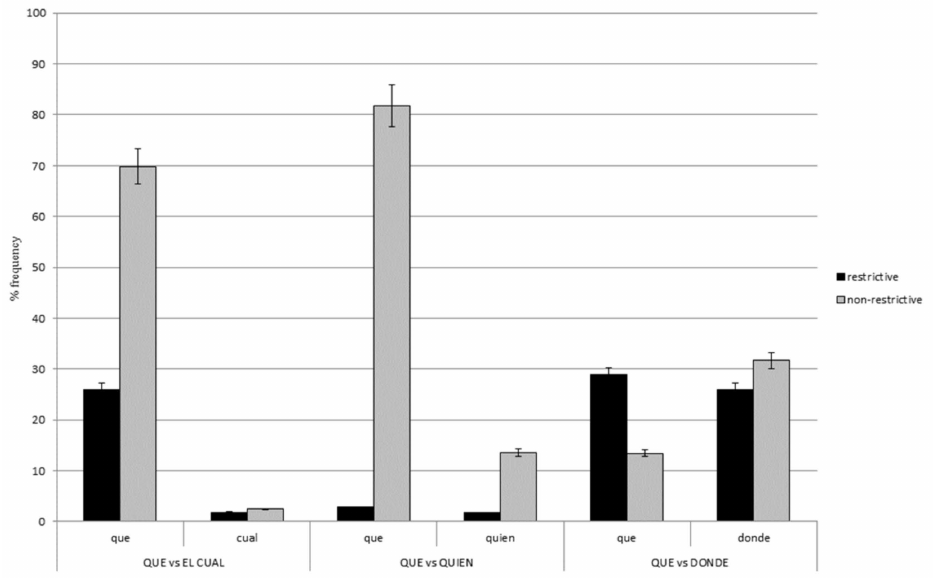
Figure 1. Pairwise comparisons of the relative frequency of the Spanish relativizers que, el cual, quien, and donde in restrictive and non-restrictive RCs in Spanish